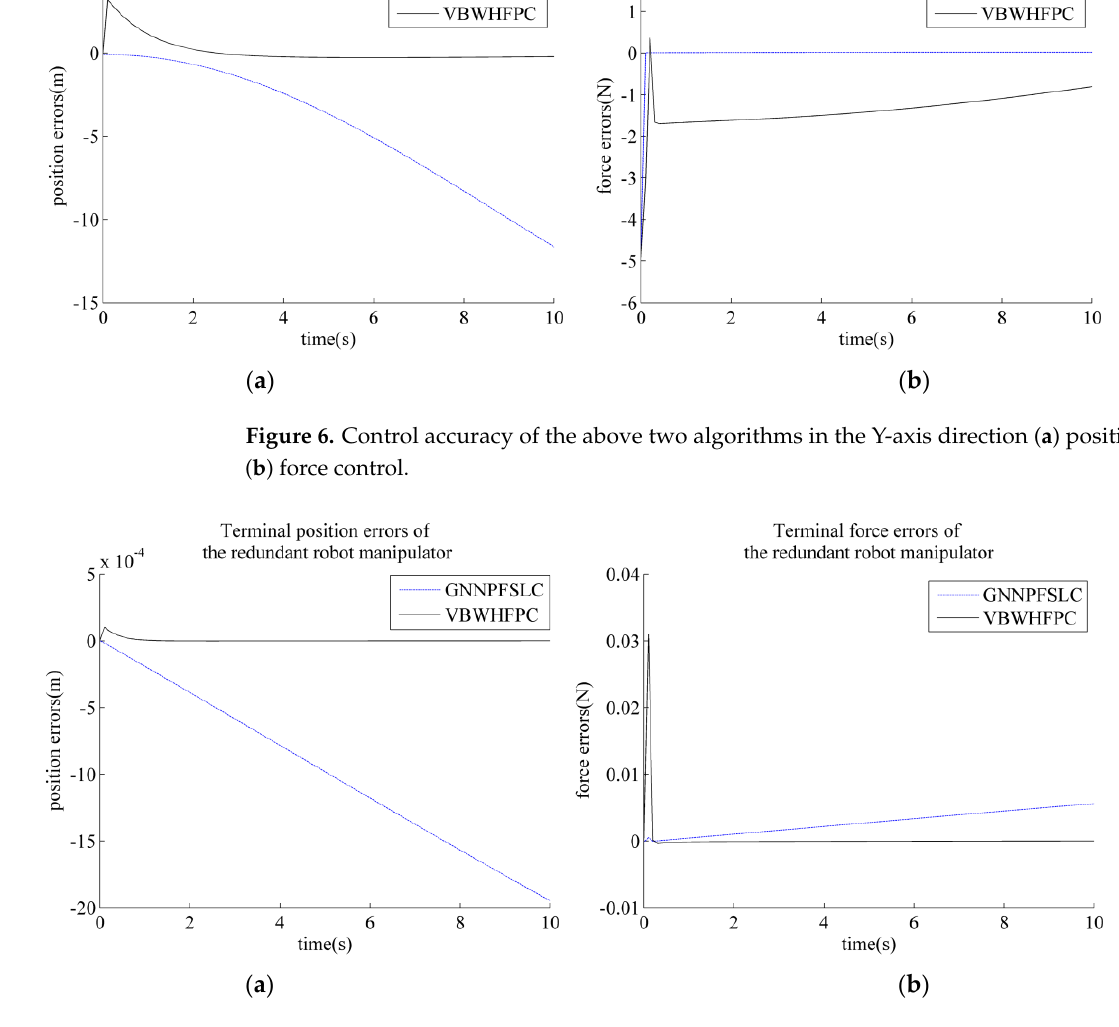
Figure 7. Control accuracy of the above two algorithms in the Z-axis direction ( a ) position control; ( b ) force control. Table 4. Position and force accuracies during the transport operation under variable